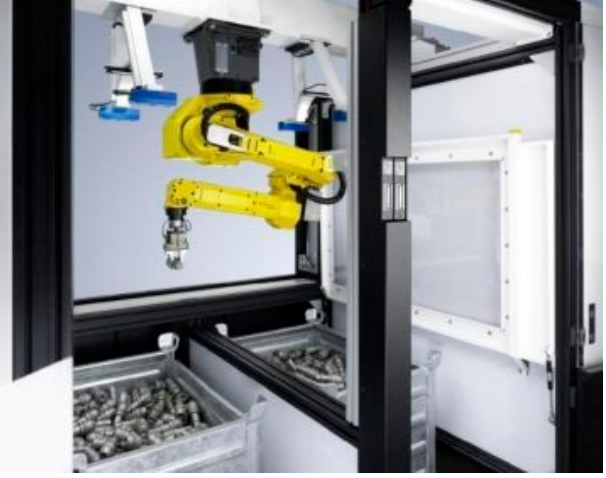
Figure 15. Bin picking [77].